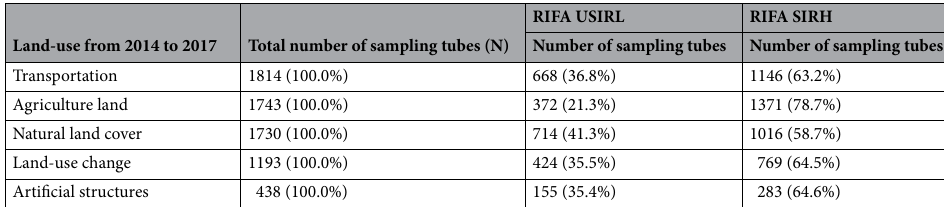
Table 1. The distribution of sampling tubes with RIFA unsuccessful invasion or remaining at low levels of invasion (RIFA USIRL) and RIFA successful invasion or remaining at the highest level of invasion (RIFA SIRH), 2018–2019 (N =